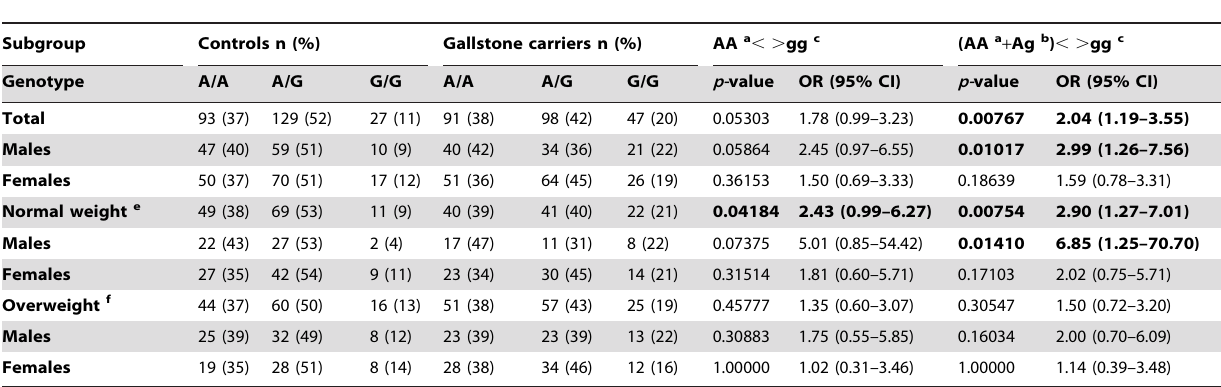
Table 2. Prevalence of gallstones and rs9514089 polymorphism in the pooled Stuttgart and Aachen cohorts.